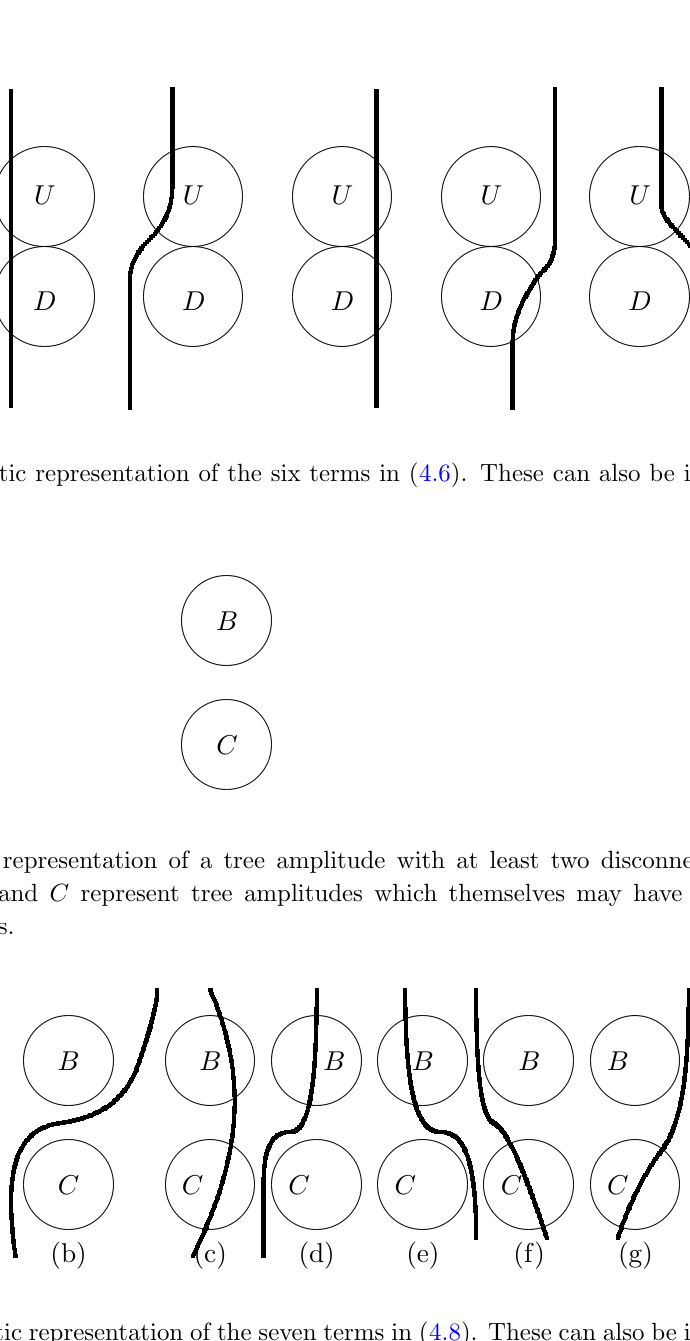
Figure 22 . Diagrammatic representation of the seven terms in (4.8). These can also be interpreted as cuts of (cid:12)gure